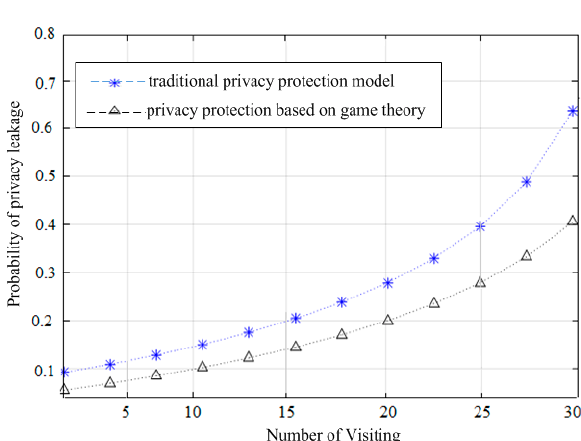
Figure 4. The probability of private information leakage between the traditional and game theory-based privacy protection models.